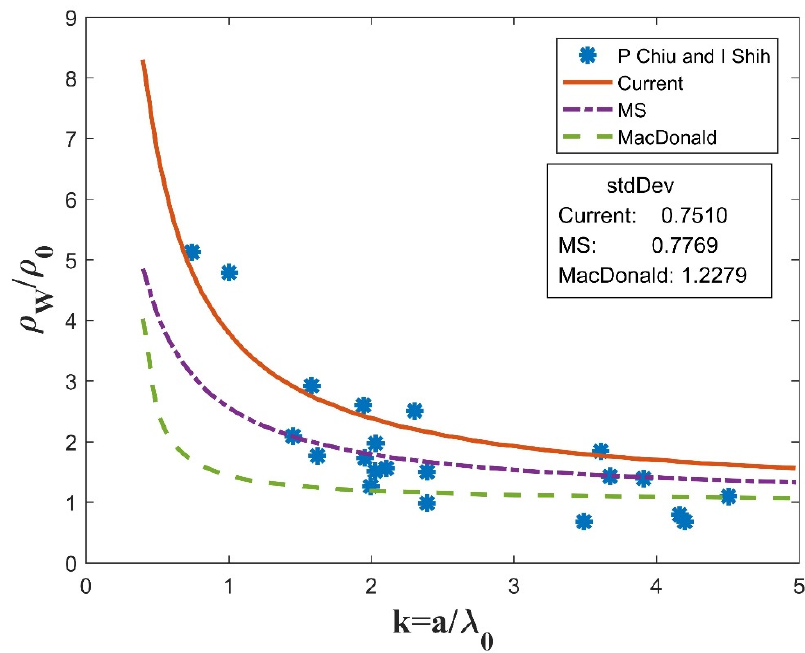
Figure 3. Comparison between numerical simulations and experiment data for Bi nanowires, with parameters p = 0.5, R = 0.5, C = 1.